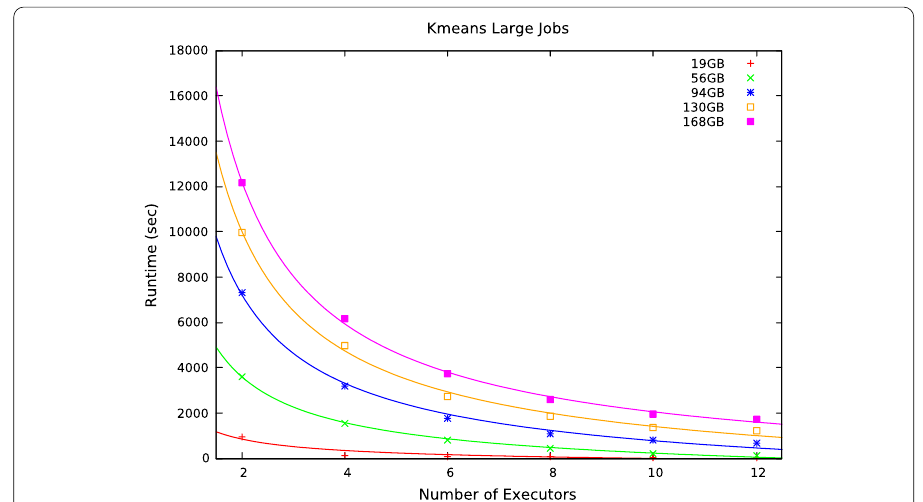
Fig. 21 Fitting the 2D plate model to Kmeans with larger problem